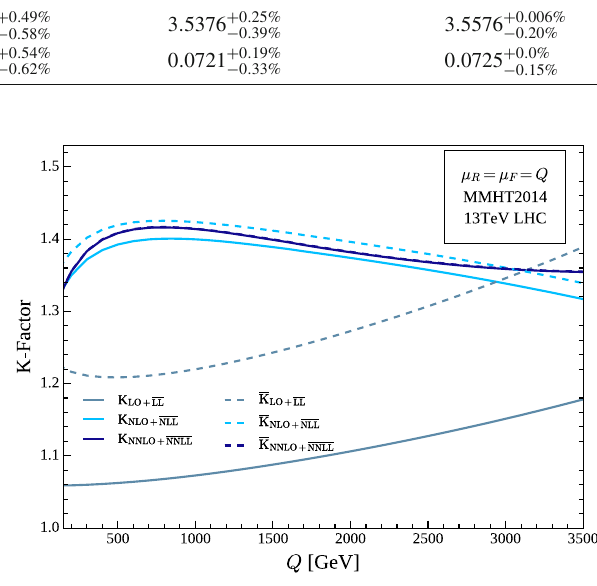
Fig. 14 Comparison between the K-factors for the N and N exponen- tiation at the central scale Q = μ R = μ F